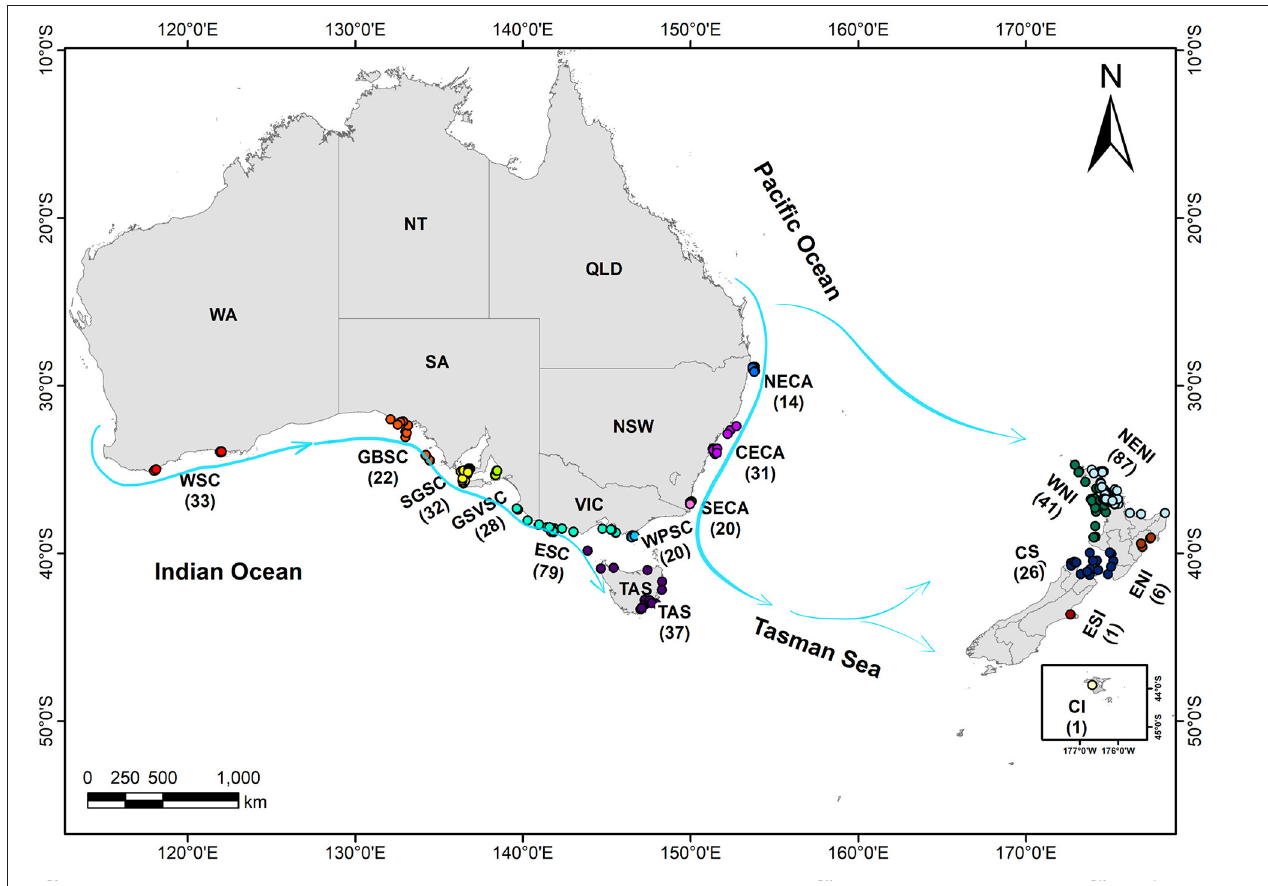
FIGURE 1 | Study area in the Australasian region showing the geolocations for 478 common dolphin ( Delphinus delphis ) samples used for the genome-wide analyses. Blue lines correspond to main current systems in Australasia. WSC, *West, Southern coast of Australia; GBSC, Great Australian Bight, Southern coast of Australia; SGSC, shelf waters in Spencer Gulf, Southern coast of Australia; GSVSC, Gulf St Vincent, Southern coast of Australia; ESC, East, Southern coast of Australia; WPSC, Wilson Promontory, Southern coast of Australia; NECA, North, Eastern coast of Australia; CECA, Central, Eastern coast of Australia; SECA, South, Eastern coast of Australia; CS, Cook Strait, New Zealand; WNI, West North Island, New Zealand; NENI, North East Island, New Zealand; ENI, East, North Island, New Zealand; CI, Chatman Island, New Zealand; ESI, East, South Island, New